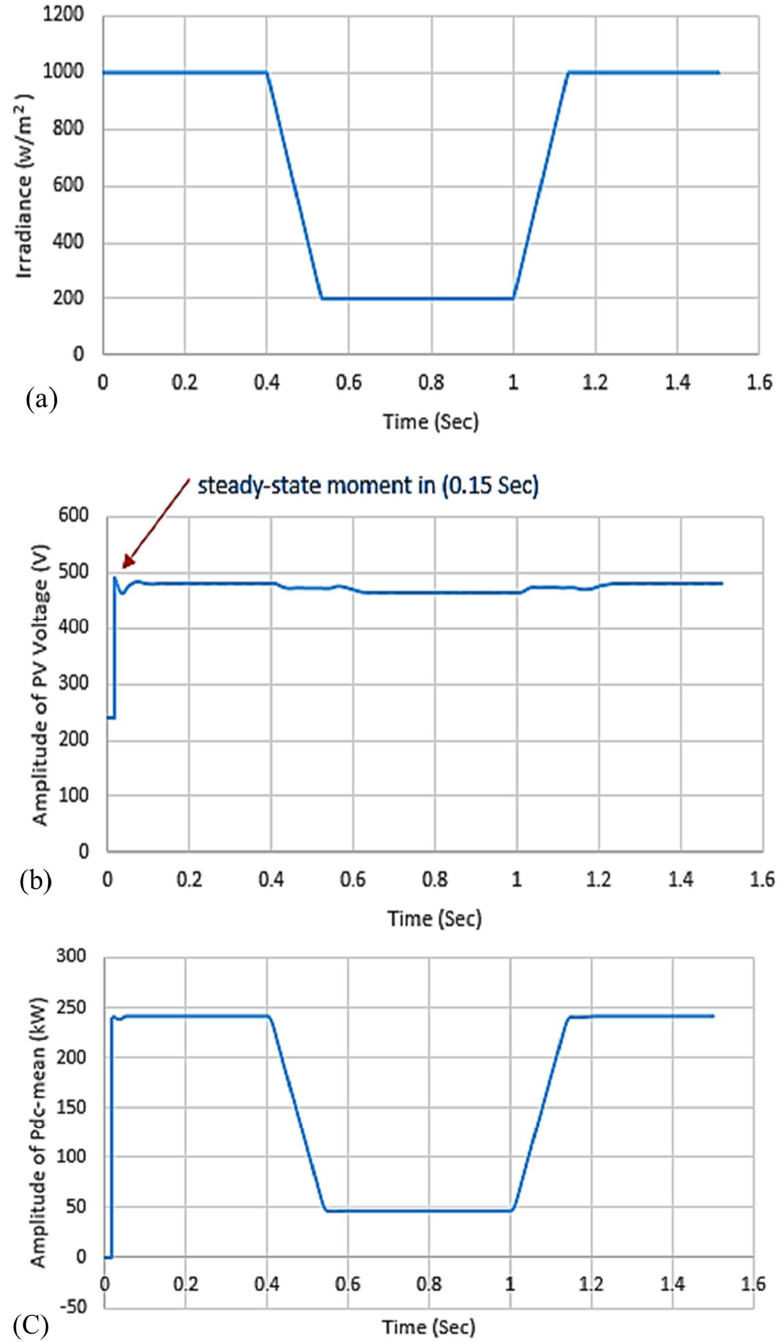
Figure 3. ( a ) Solar irradiance at cell temperature of 45 °C. ( b ) The variation of PV voltage under various irradiance levels. ( c ) the variation of power extracted from PV array under various irradiance levels.